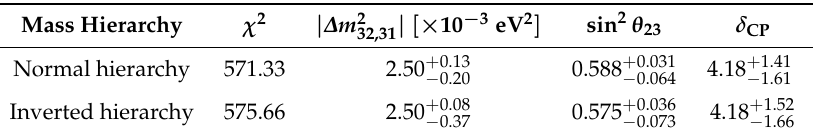
Figure 1. ( a ) Data and MC comparison for the entire SK data divided into 19 analysis samples. ( b ) The 90% C.L. constraint of oscillation parameters using SK atmospheric data together with other experiments (T2K [46], NovA [47], IceCube [48] and MiNOS [49]) assuming the normal hierarchy. The original figures are adapted from Ref. [14]. Table 2. Result of oscillation analysis from atmospheric neutrino data taken in SK assuming sin 2 θ 13 = 0.0219 ± 0.0012